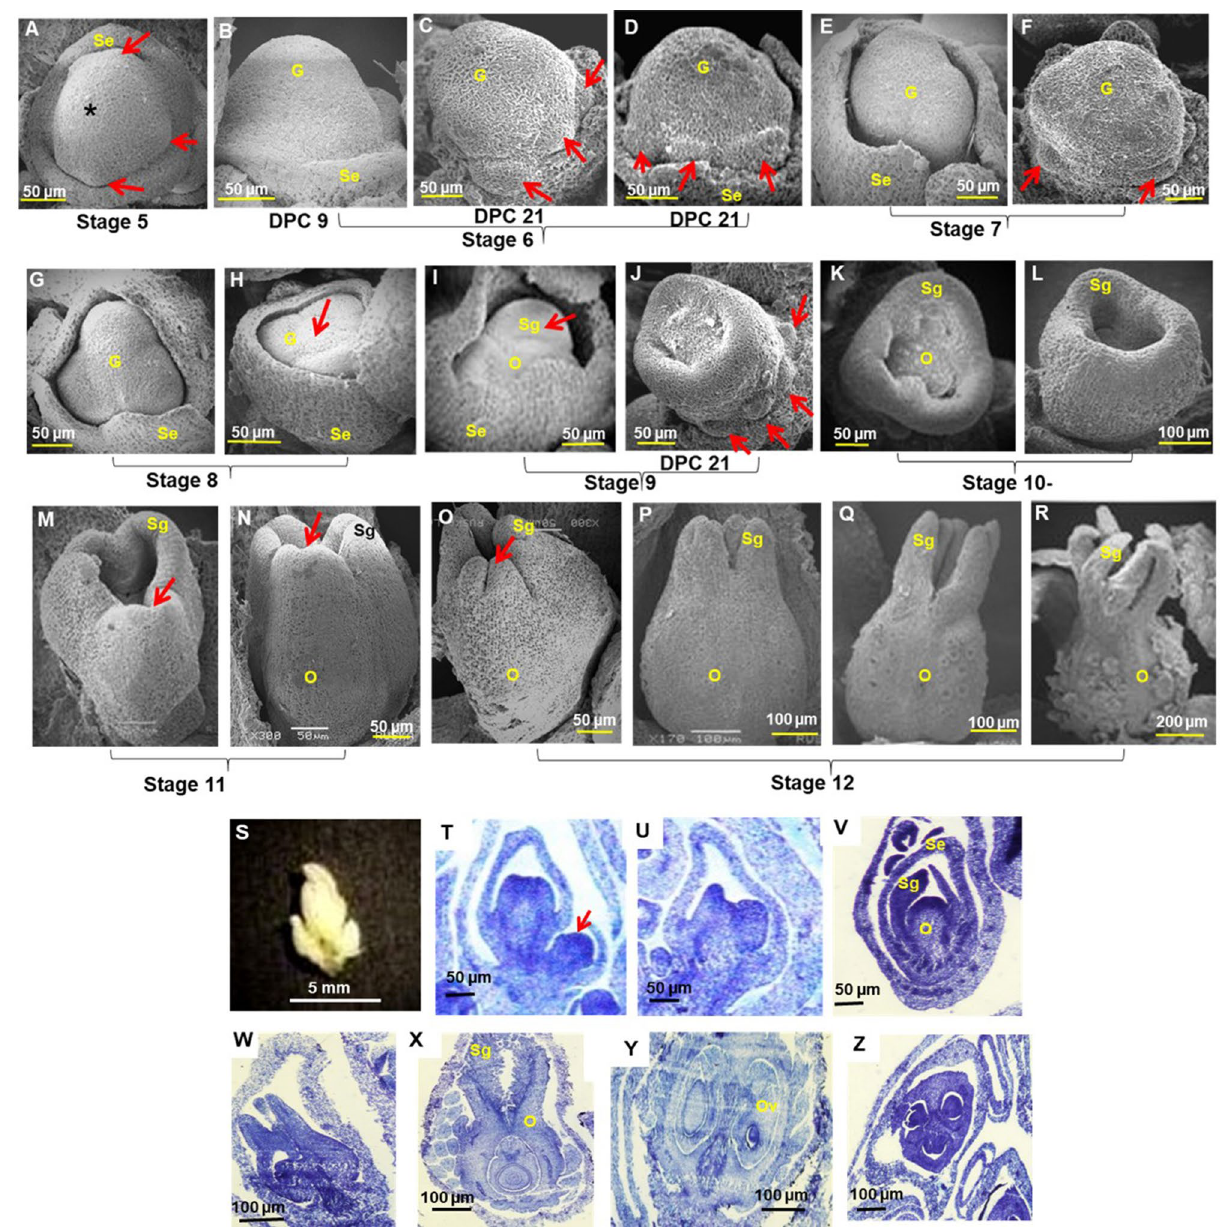
Figure 5. Stages of female flower development. Stages 1–4 are similar to male flowers ( A ) Stage 5 with stamen primordia (arrows). Asterisk indicates floral meristem. ( B–D ) Growth of central floral meristem (stage 6). ( E,F ) Cup-shaped gynoecium (stage 7). ( G,H ) Triangular gynoecium with central circular ovary (arrows) at stage 8. ( I,J ) Development of stigma primordia (arrow) at stage 9. Stamen primordia (arrows) are prominent in ISF line DPC 21. ( K,L ). Growth of stigma (stage 10) ( M,N ) Bifid stigma formation (stage 11). ( O–R ) Ovary and stigma development (stage 12). Stamen primordia (arrows) are distinct in ISF line DPC 21 from stages 6–9. ( S ) Female flowers in triplet. ( T–Z ) Histological sections showing stigma and ovule development. Scale bars are shown below. Sections are of ×40 magnification. B bract, G gynoecium, O ovary, Se sepal, Sg